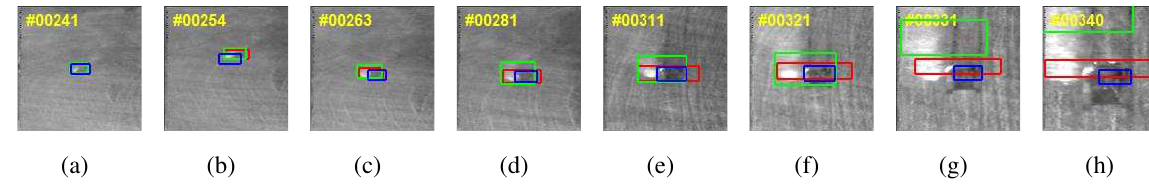
Figure 4. Tracking results of three trackers for sequence